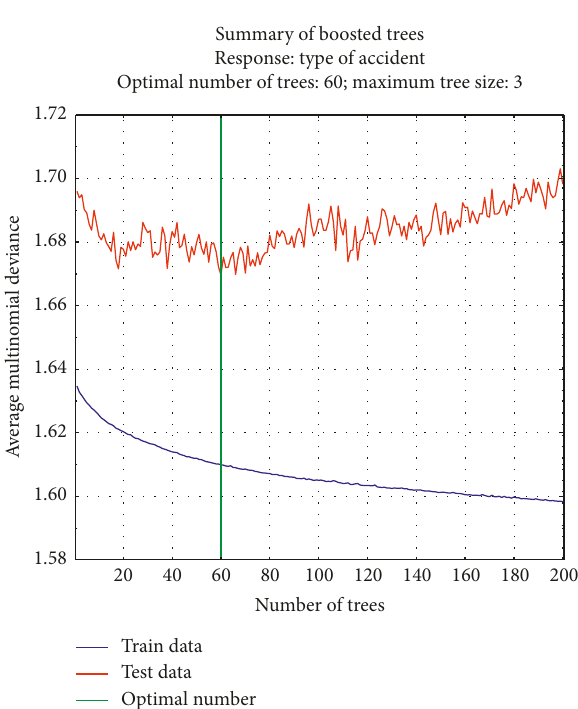
Figure 4: Training results of the SGB